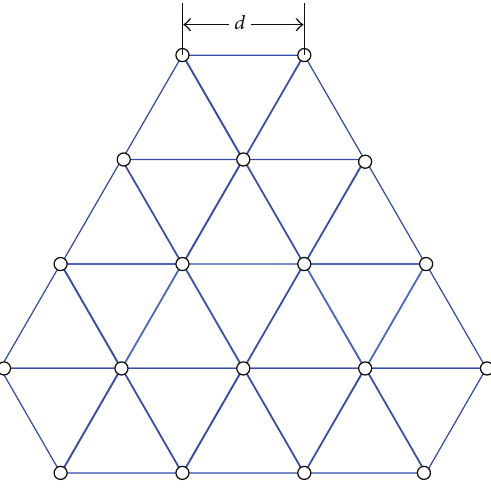
Figure 1: Architecture of